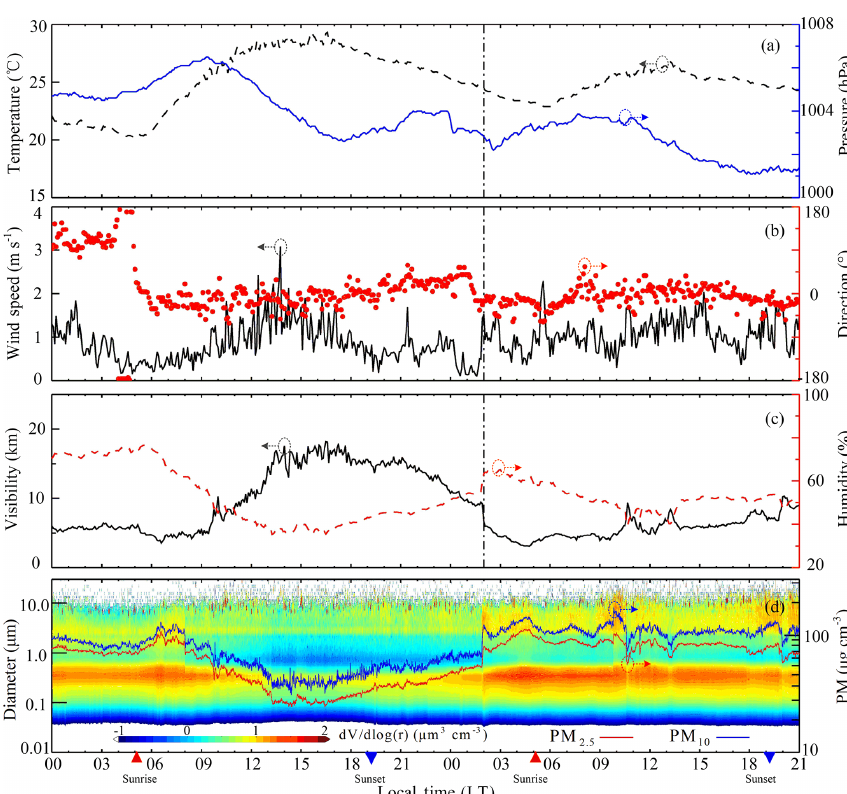
Figure 4. The simultaneous measured surface meteorological parameters during the experiment from 1 June 2018 to 2 June 2018. From (a) to (d) the parameters are (a) temperature and pressure; (b) wind velocity and wind direction; (c) visibility and relative humidity; and (d) logarithmic aerosol volume size, PM 2 . 5 , and PM 10 concentration. The dashed vertical lines in (a) – (c) indicate the time when there is a sudden enhancement of PM 2 . 5 in (d) . Table 2. The correlations between BLH and PM 2 . 5 and the inverse fitting results. Time Before precipitation After precipitation ABL CBL CBL RL (or SBL)